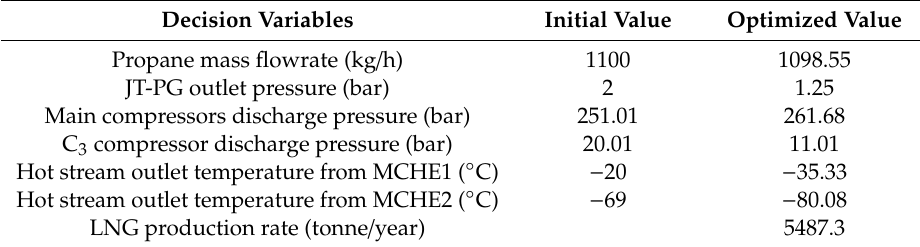
Table A6. Optimization results for propane pre-cooled